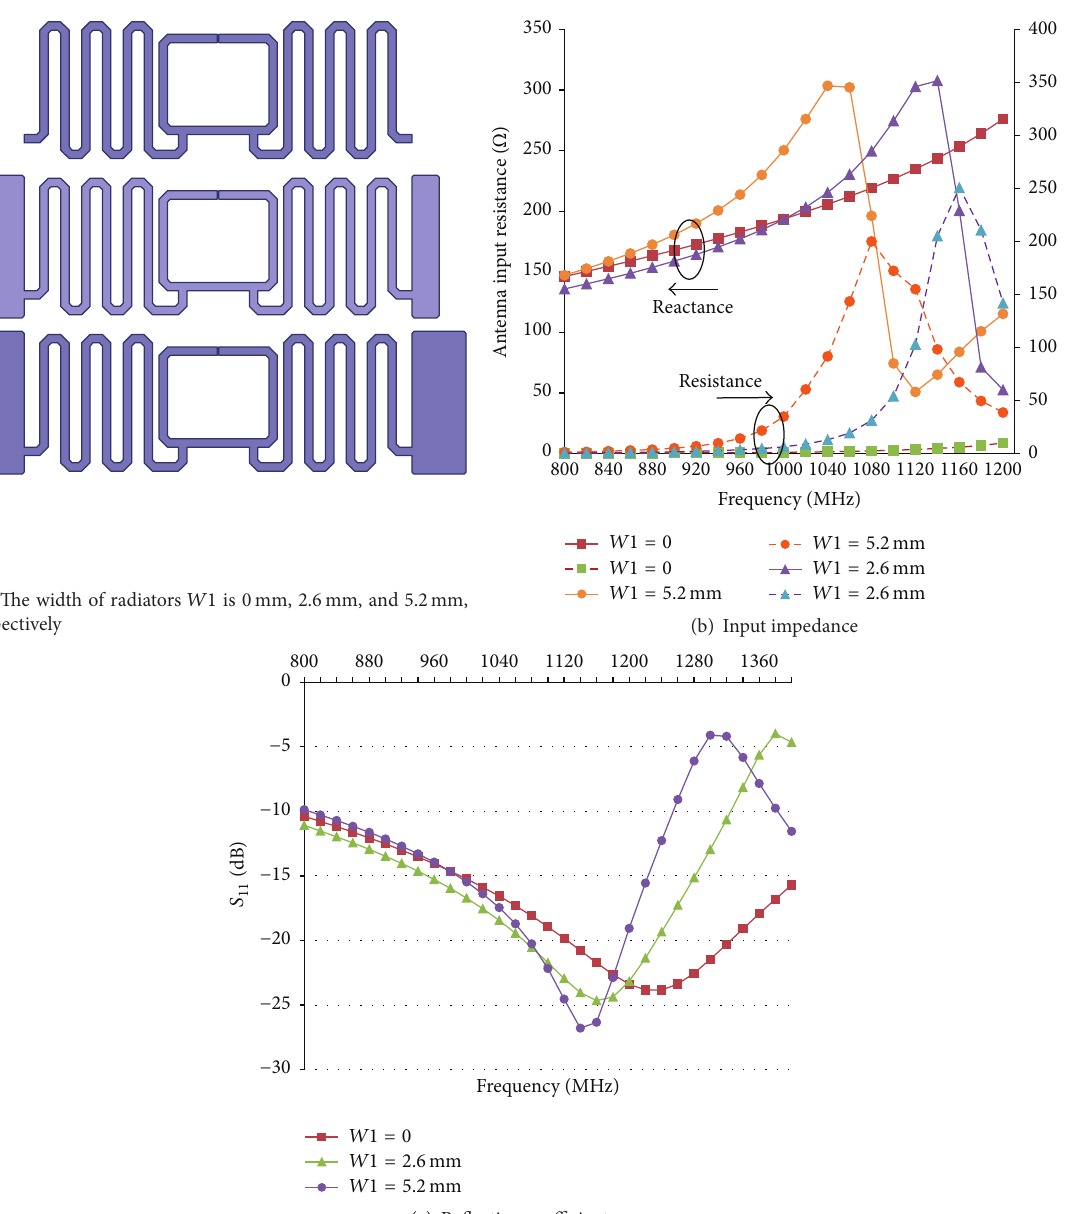
Figure 4: Simulated input impedance and reflection coefficients of tag antenna with different